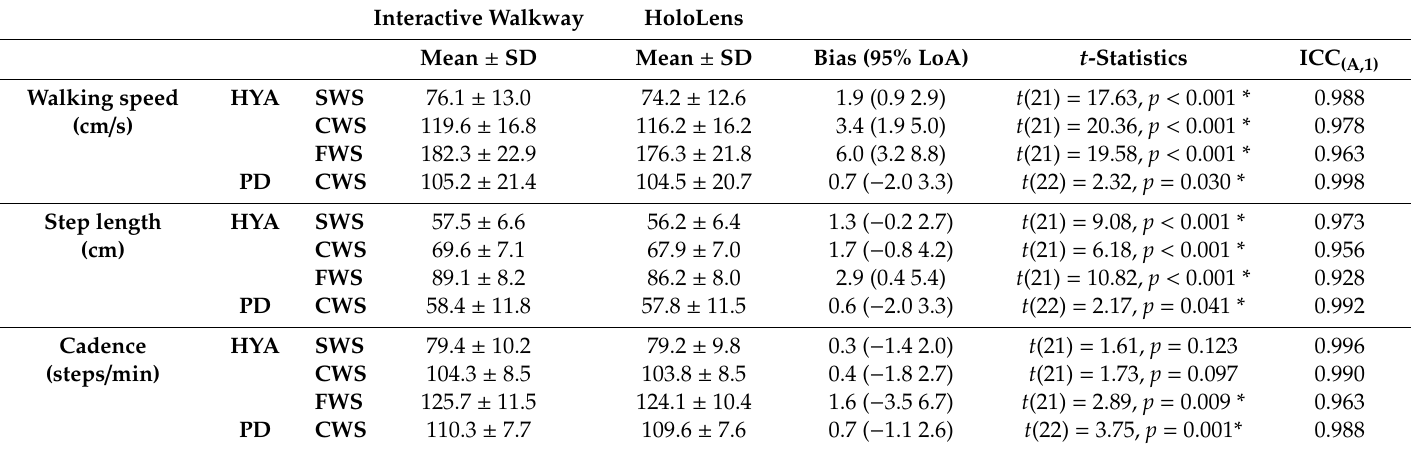
Table 3. Concurrent validity (i.e., between-systems agreement) for spatiotemporal gait parameters of instructed slow walking speed (SWS), comfortable walking speed (CWS) and fast walking speed (FWS) conditions in healthy young adults (HYA) and CWS in people with Parkinson’s disease (PD), presented for trial